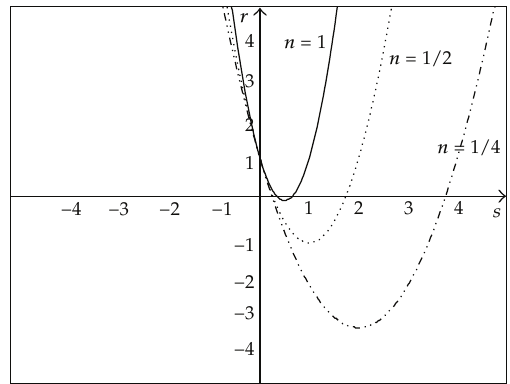
Figure 1: variation r against s for di ff erent values of n (cid:2)(cid:4) 1 / 4 , 1 / 2 , 1 (cid:3)